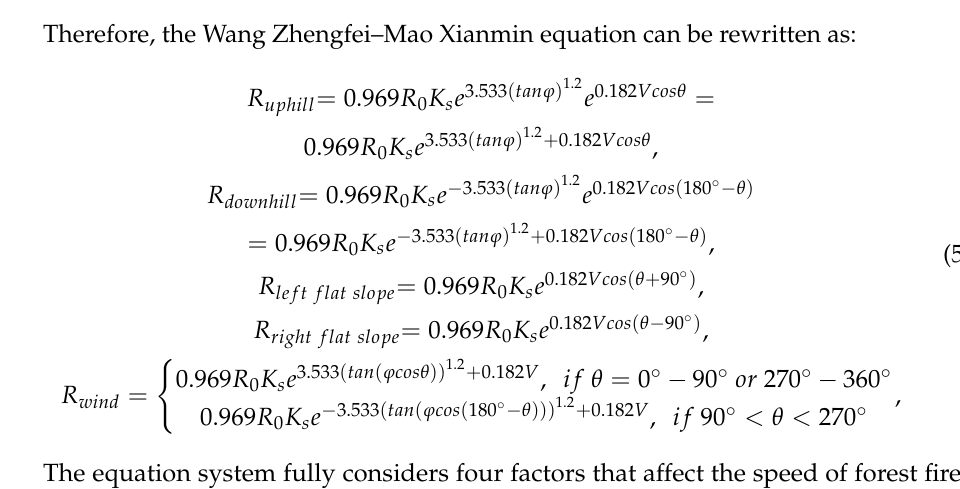
Figure 3. Comparison of fitting results between Formulas (3) and (4). The black solid dots indicate the original data in Zhengfei Wang’s paper (WZF), the red line indicates the results of Xianmin Mao (MXM) and the blue line indicates the results after refitting.